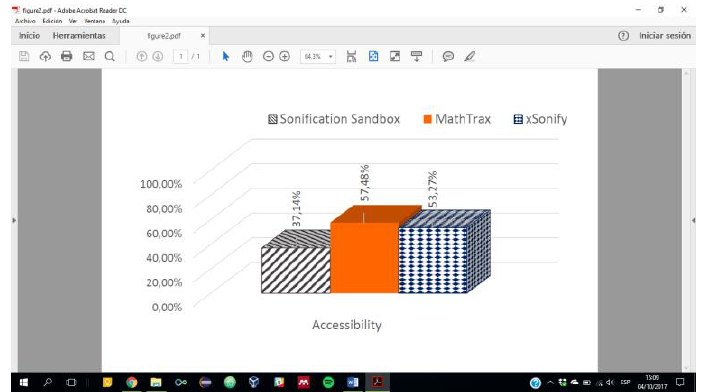
Figure 1. Results of the analysis of